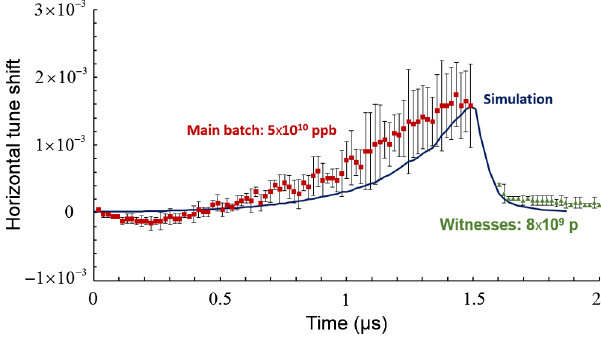
FIG. 10. Results the of electron cloud simulation agree with the measured horizontal tune shift. Beam: 5 × 10 10 ppb, 80 bunches, followed by one witness bunch of 0 . 8 × 10 10 p at various positions. The gap between the high-intensity batch and the witness is due to the rise time of the injection kickers.